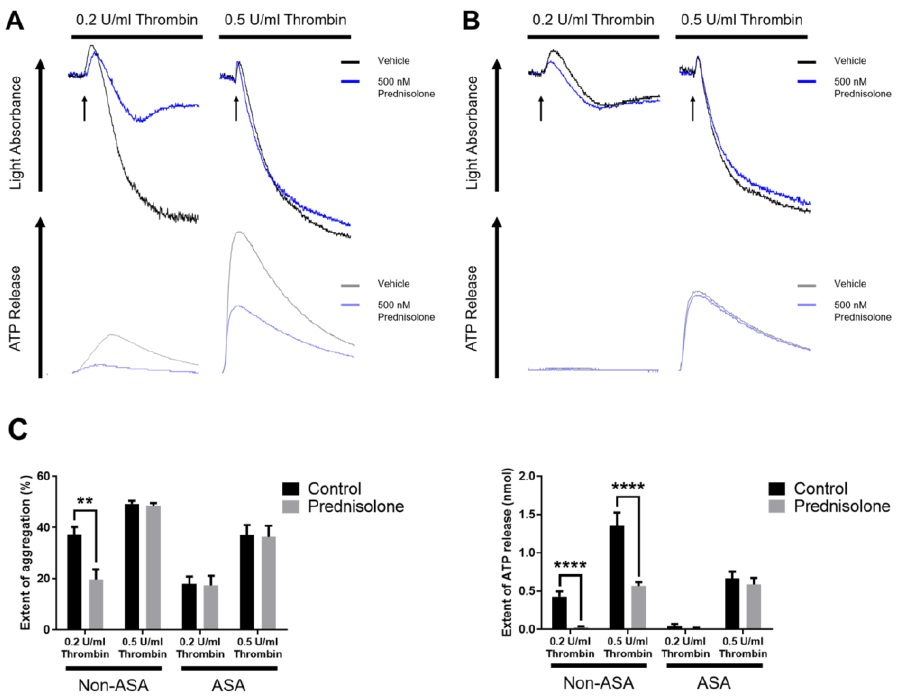
Figure 3. The effect of prednisolone on thrombin-induced platelet aggregation and secretion. ( A ) Non-aspirinated and ( B ) aspirinated washed platelets were stimulated with 0.2 U/mL and 0.5 U/mL thrombin in the presence or absence of 500 nM prednisolone, and platelet aggregation and secretion were measured. The entire set of data represents three separate experiments ( n = 6). ( C ) The extent of aggregation and dense granule secretion were quantified from panels A and B. Data are presented as mean ± SE. **, p < 0.01; ****, p < 0.0001.